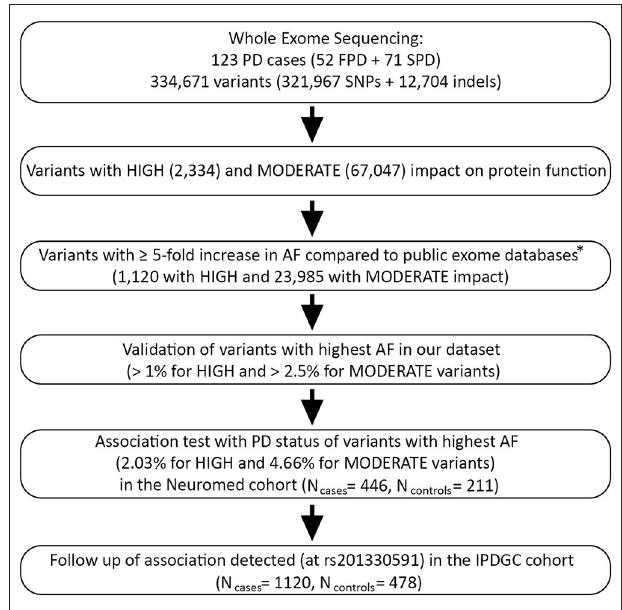
FIGURE 1 | Bioinformatic pipeline applied in the present study for PD causative variants prioritization and case-control association testing. PD, Parkinson disease; FPD/SPD, familial/sporadic Parkinson disease; IPDGC, International Parkinson Disease Genetics Consortium (22). *Public exomes databases: 1000G EUR, European Sample of the 1000 Genomes project, phase 3 ( N = 503) ( 42); ESP EA, NHLBI Exome Sequencing Project 6500 release si-v2, European ancestry ( N = 4,300) ( 43); ExAC NFE, Exome Aggregation Consortium version 0.3.1, Non-Finnish Europeans ( N = 33,370)